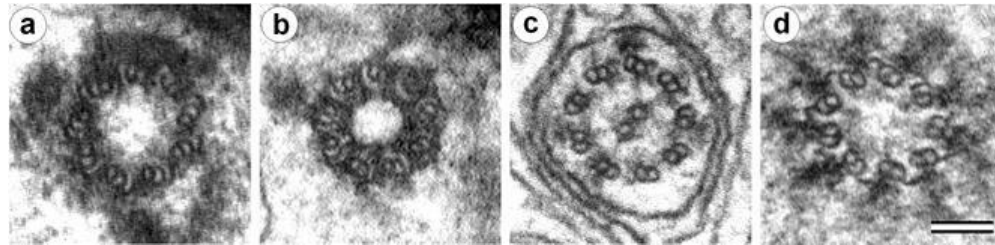
Figure 5. Four types of MT-contained structures: ( a ) proximal centriole in the early pig spermatid—formula “9 × 3 + 0”; ( b ) centriolar adjunct in the early pig spermatid—formula “9 × 2.5 + 0”; ( c ) flagellum in early pig spermatid—formula “9 × 2 + 2”; and ( d ) the cilia-like structure structurally similar to the primary cilium of mammals in the spermatid of the wasp Anisopteromalus calandrae —formula “9 × 2 + 0”. Scale bar: ( a – d ) 100 nm. ( a – c ) from [150]; and ( d ) from [20].